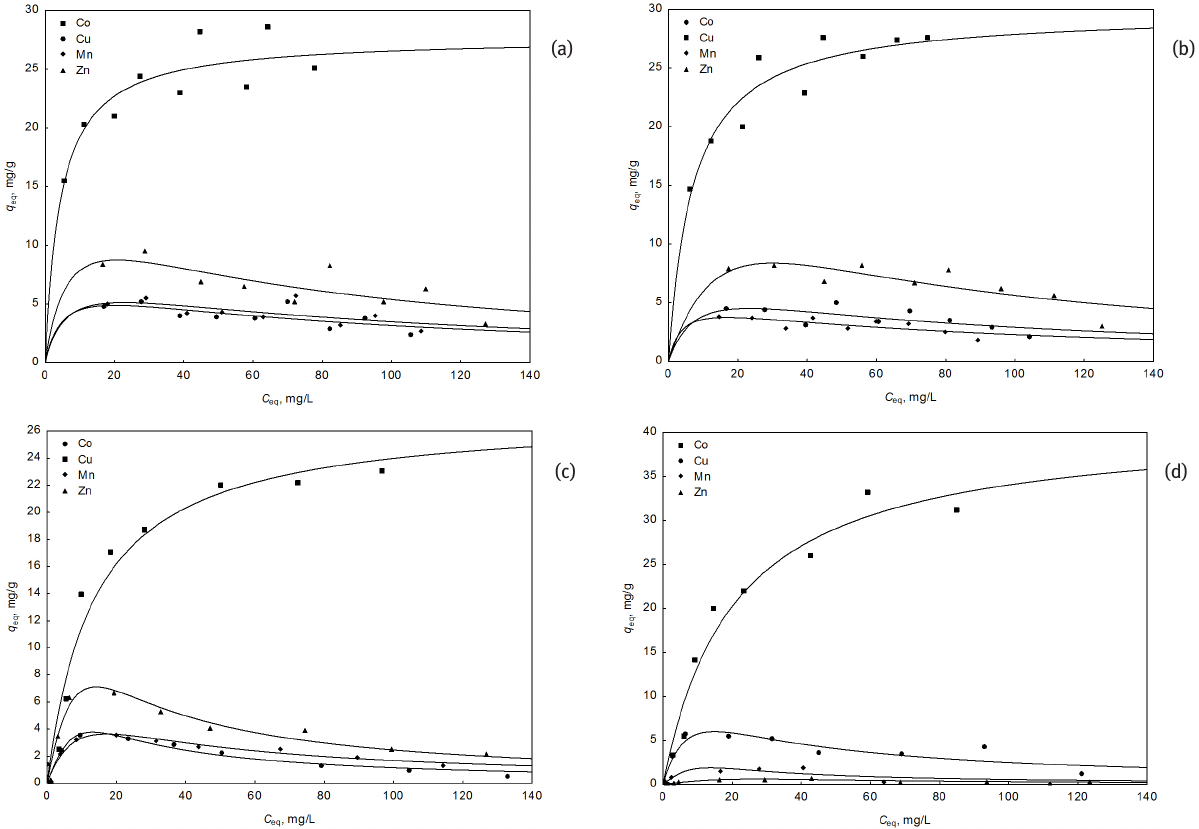
Figure 3: The equilibrium of biosorption of microelement ions in four-cation system: a) Cl - :NO 3- :SO 42- = 4:0:0, b) Cl - :NO 3- :SO 42- = 3:0:1, c) Cl - :NO 3- :SO 42-